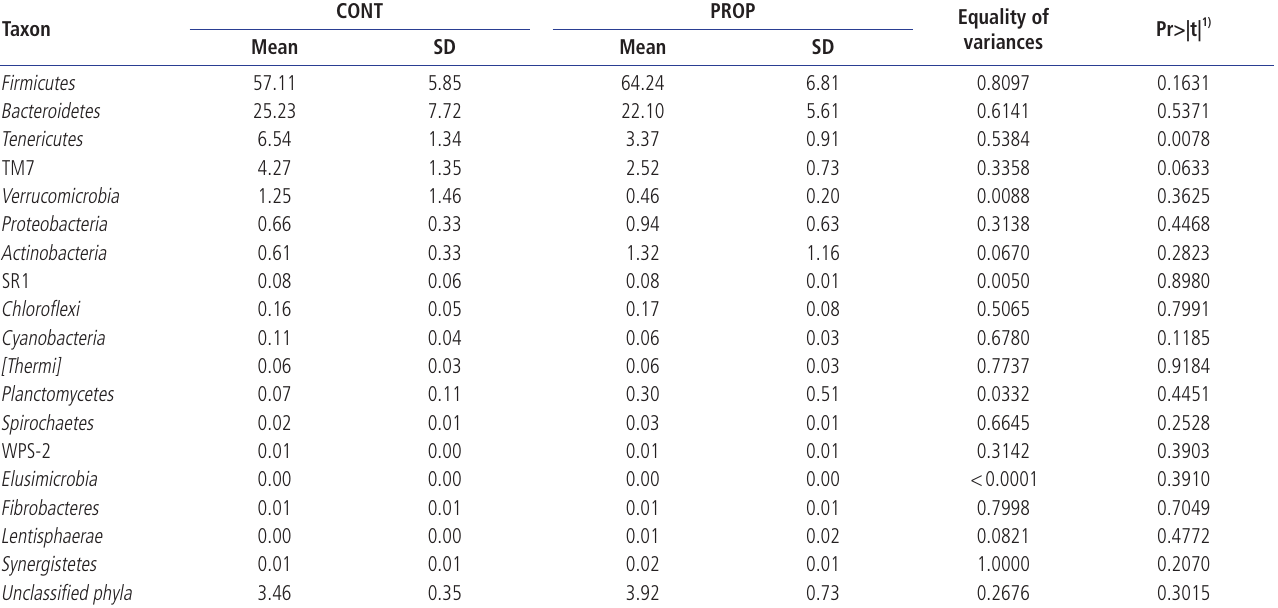
Table 2. Effect of calcium propionate feeding on the difference in most abundant phyla (as a percentage of the total sequences) in the rumen bacterial